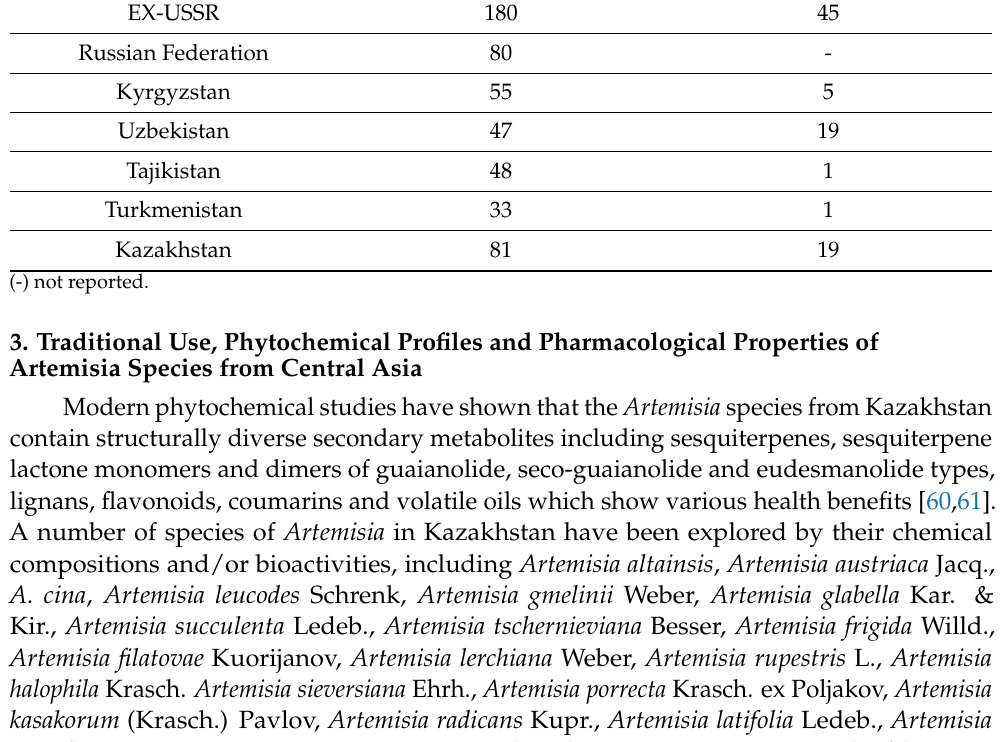
Table 1. Distribution of Artemisia L. genus in Central Asian and Russian countries. Countries Number of Present Species Number of Endemic Species China 186 82 EX-USSR 180 45 Russian Federation 80 - Kyrgyzstan 55 5 Uzbekistan 47 19 Tajikistan 48 1 Turkmenistan 33 1 Kazakhstan